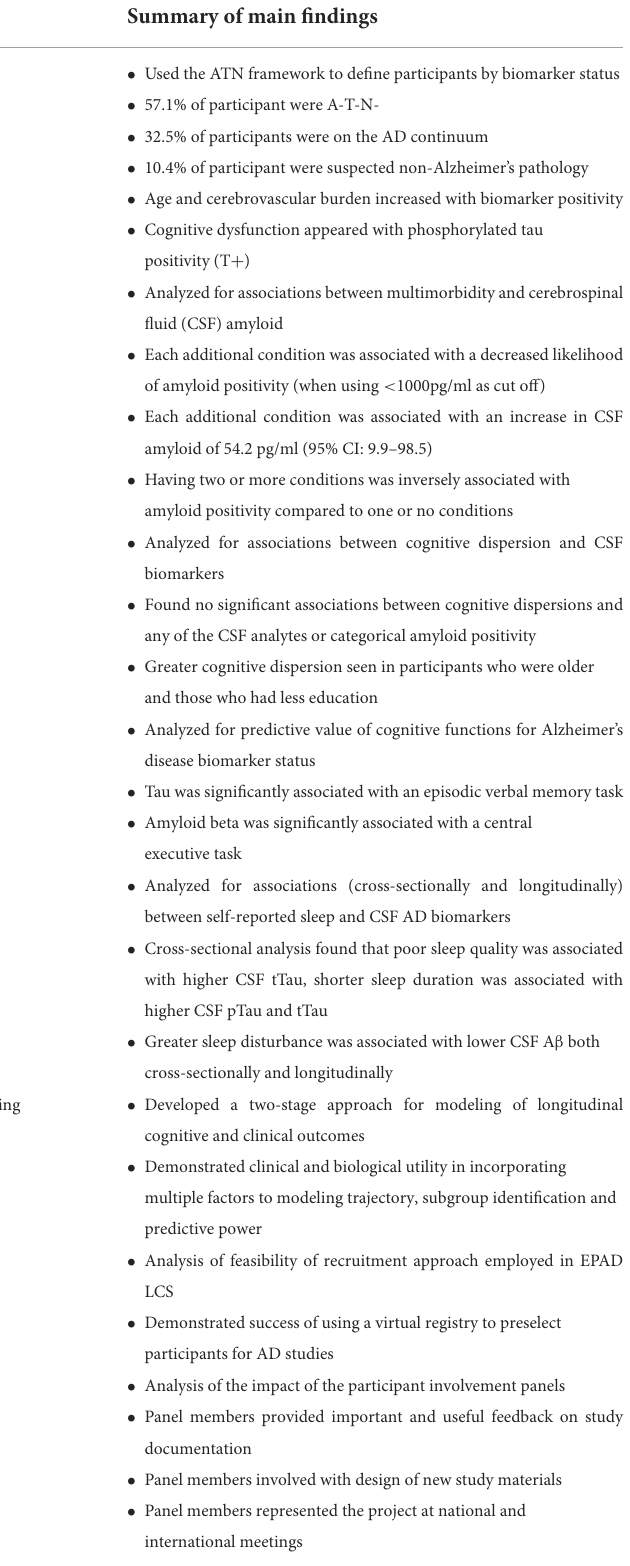
TABLE 3 Overview of results papers originating from analysis of EPAD data or EPAD